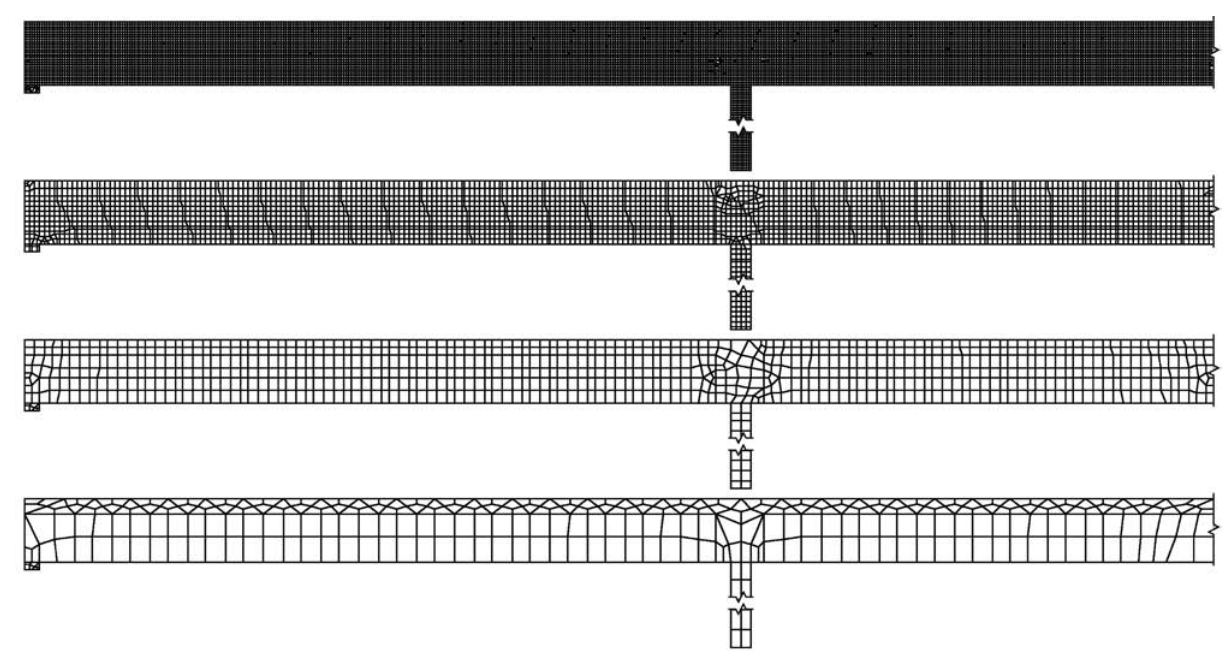
Fig. 6. FE models of the